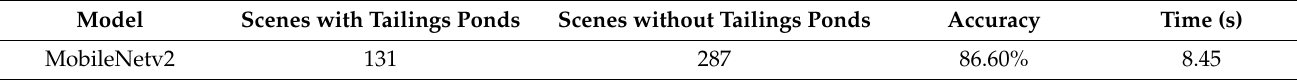
Table 4. Prediction results of the MobileNetv2 model on large scene remote sensing